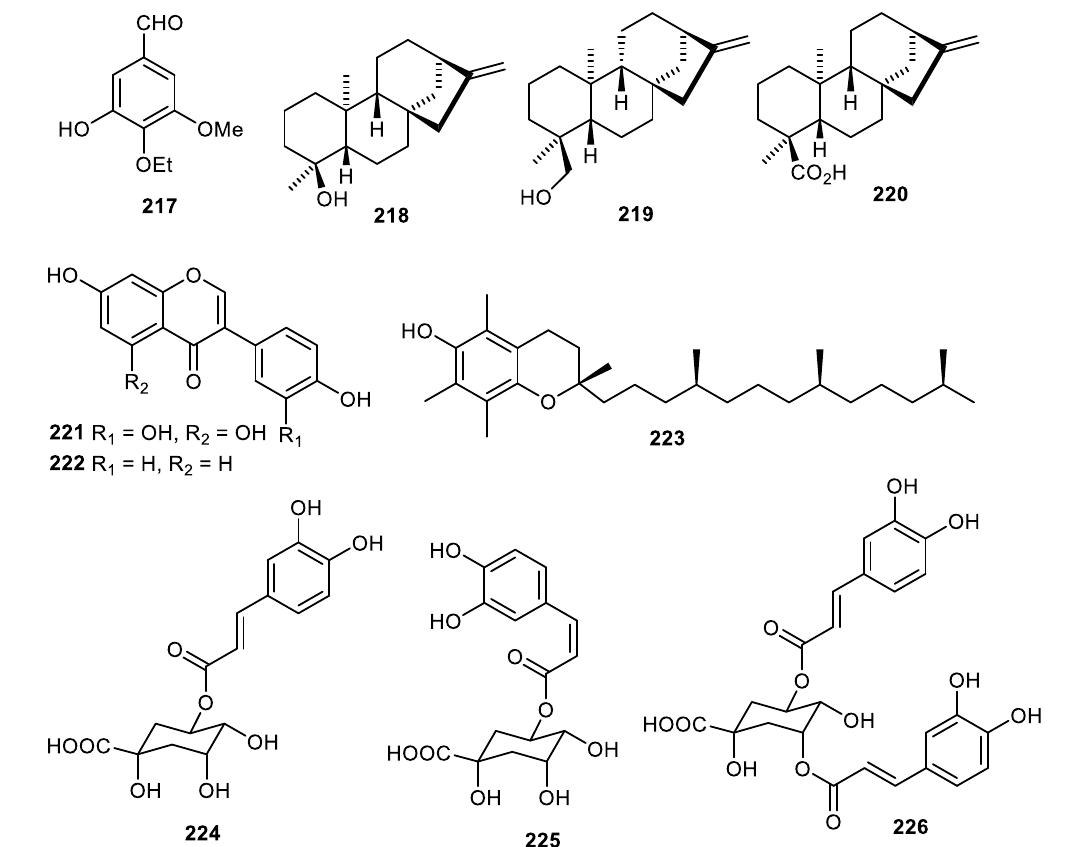
Figure 27. Structures of compounds 217 – 226 .